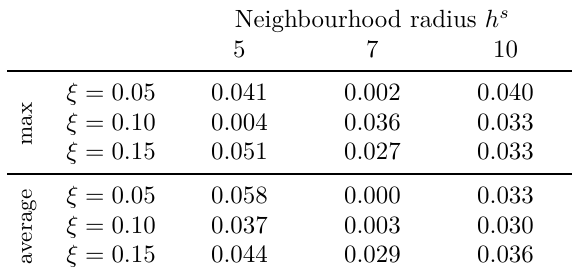
Table 5. Values of the volume fraction error ε φ , depending on the magnitude of artificially introduce noise ξ , neighbourhood radius h s , and the type of pooling layer used (max or average).